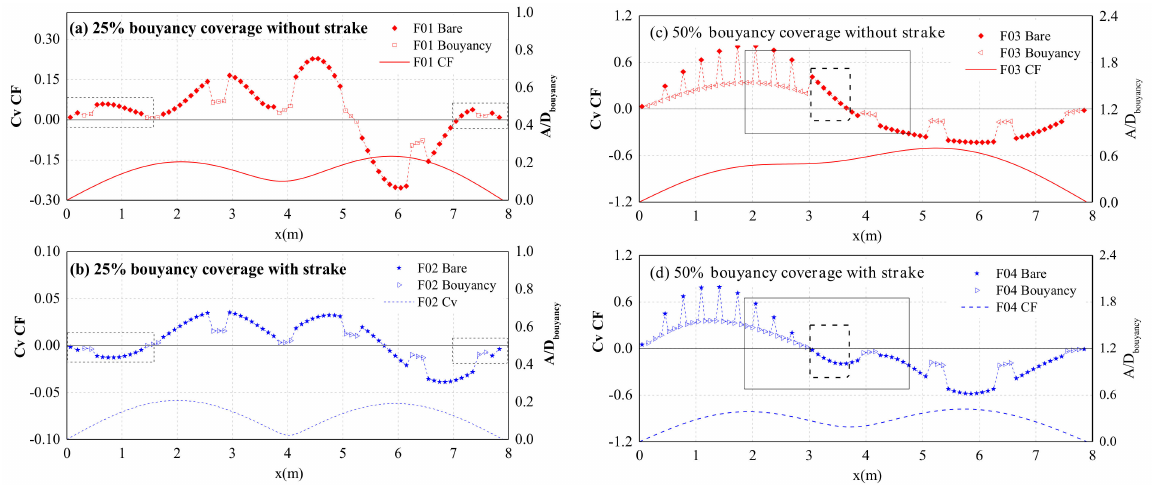
Figure 11. The excitation coefficient and displacement RMS values of the pipe in CF direction are distributed along pipe length (Cv CF is the excitation coefficient in CF direction; A/D bouyancy is the ratio of VIV displacement amplitude to outer diameter of buoyancy